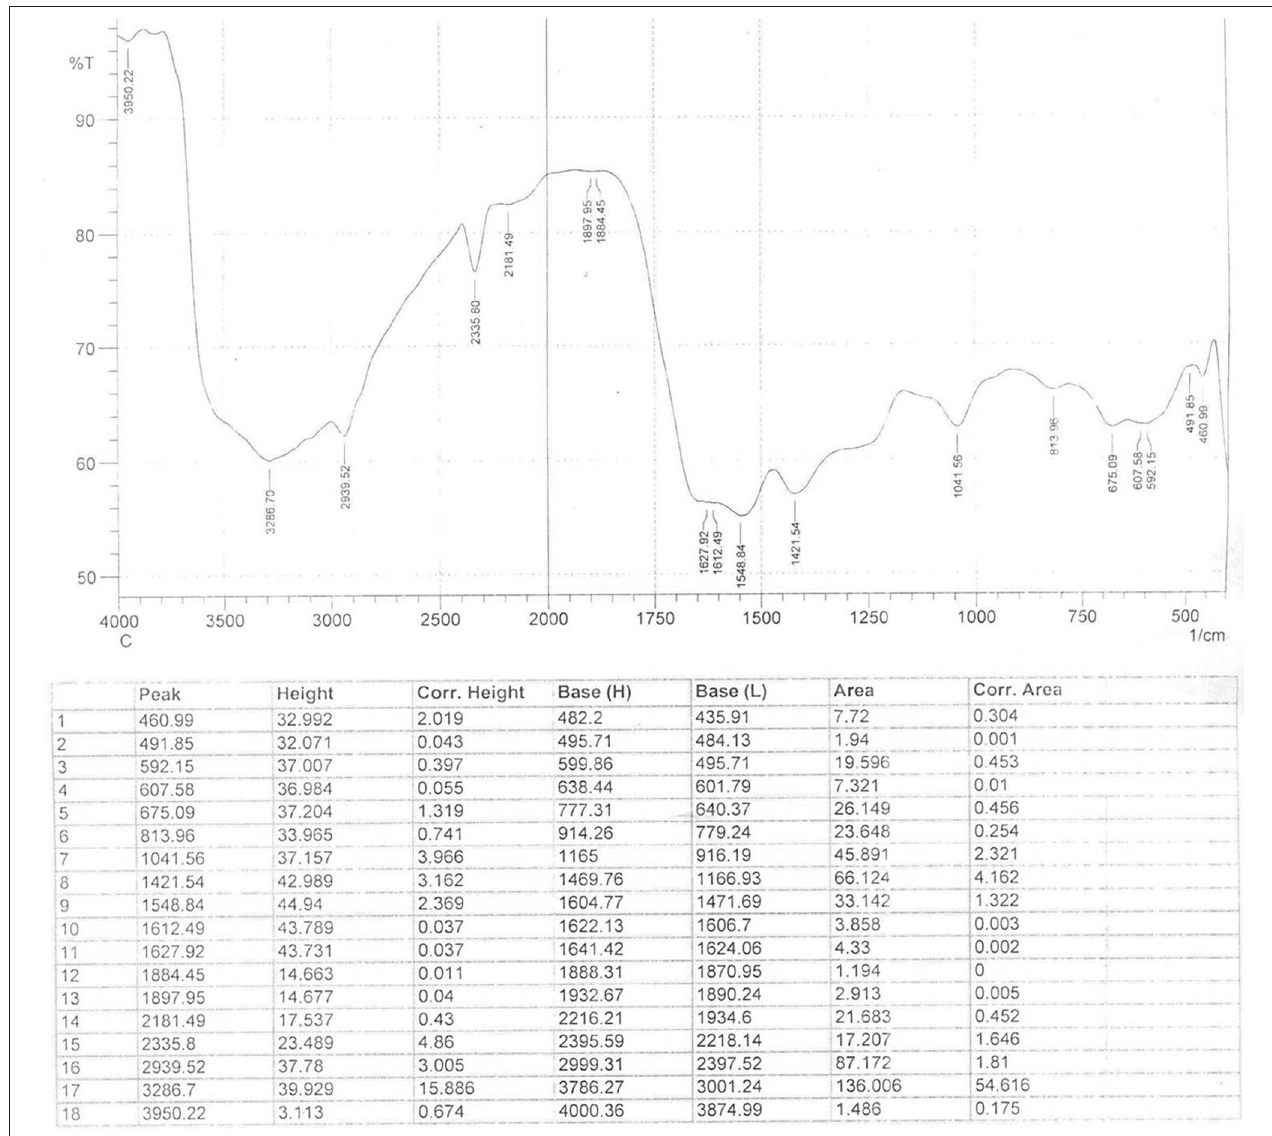
FIGURE 1 | FTIR spectrum analysis of bio-fabricated CuO-NPs.